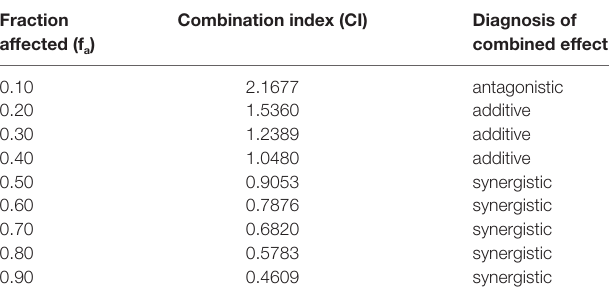
TABlE 2 | Calculated values for the combination index of curcumin-BCP in combination (molar ratio, 1:3.6).for the effect of reduction of IL-1β mRNA levels in